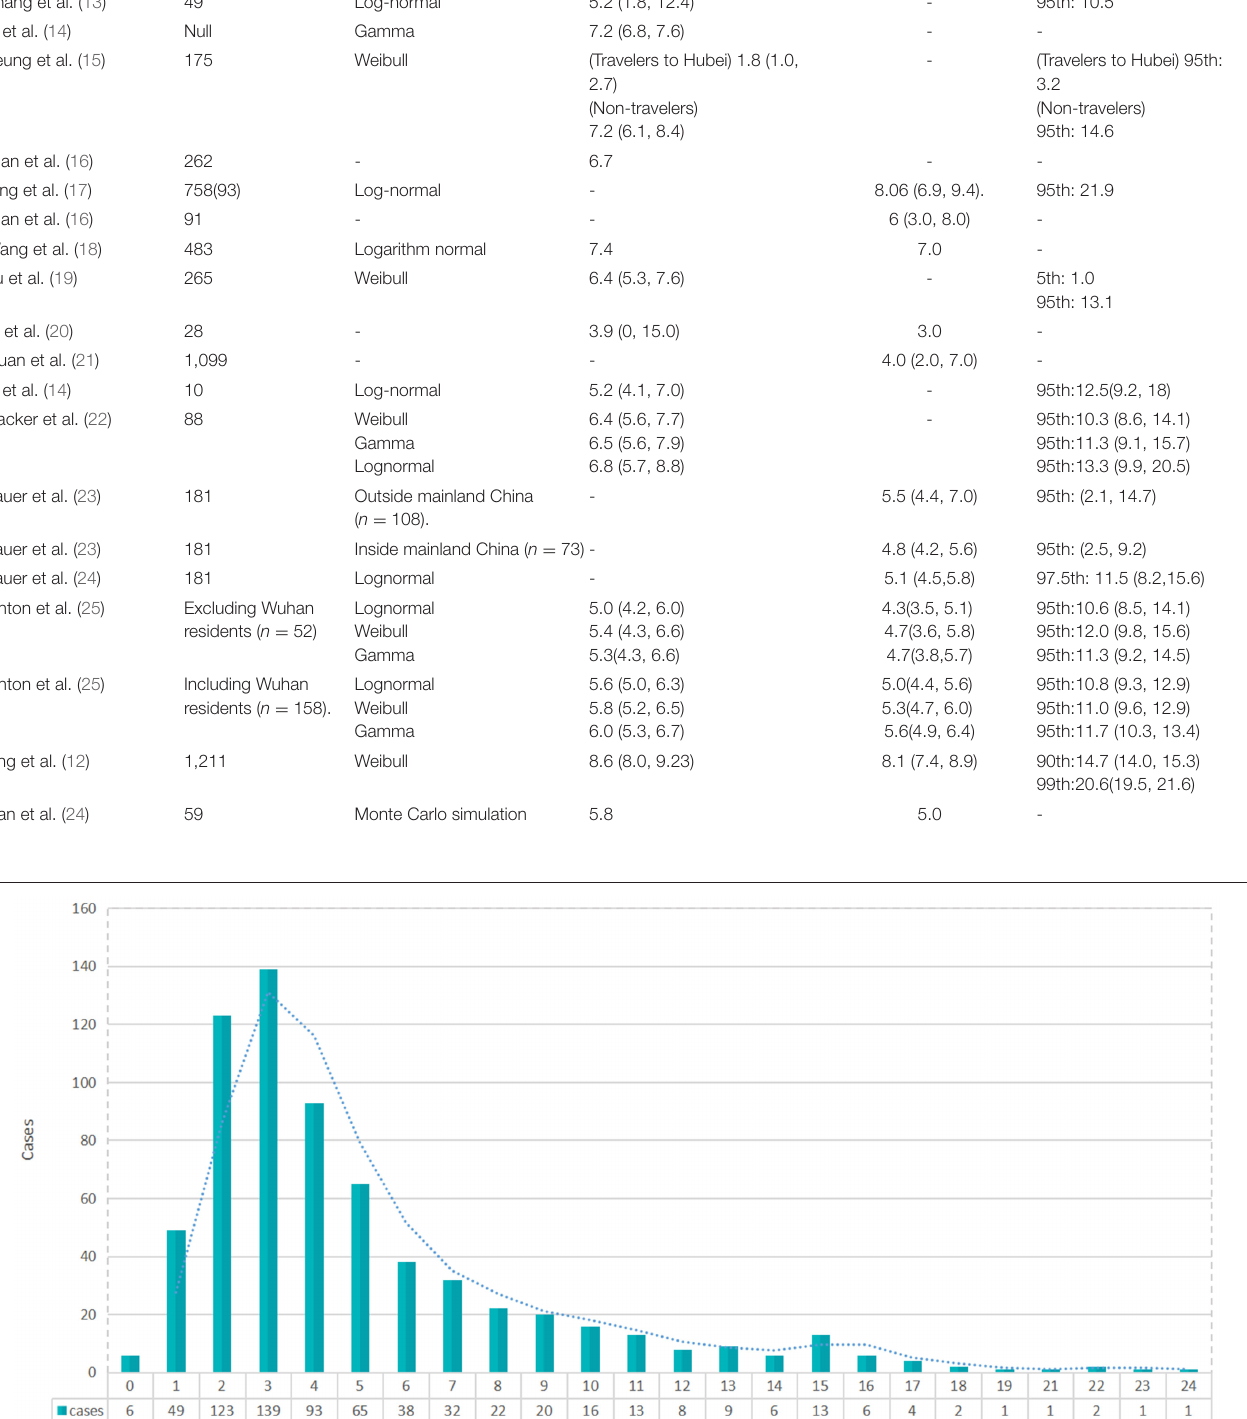
Frontiers in Medicine |